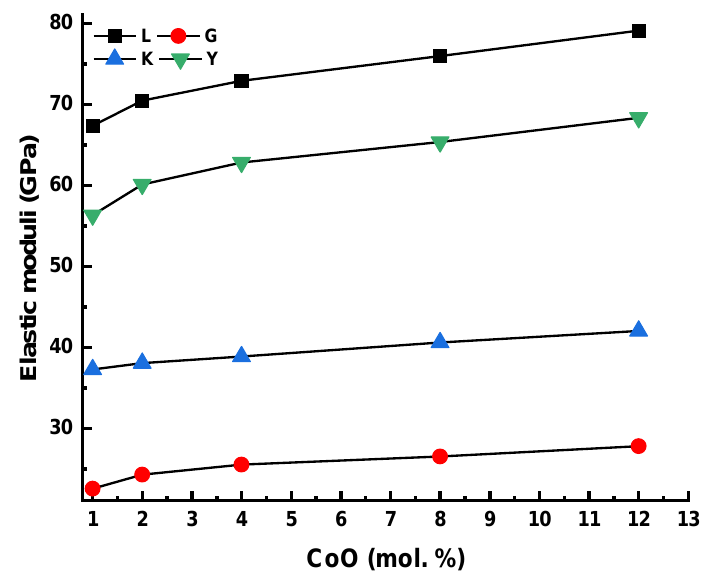
Figure 7. Longitudinal modulus (L), shear modulus (G), bulk modulus (K), and Young’s modulus as a function of the glass composition.